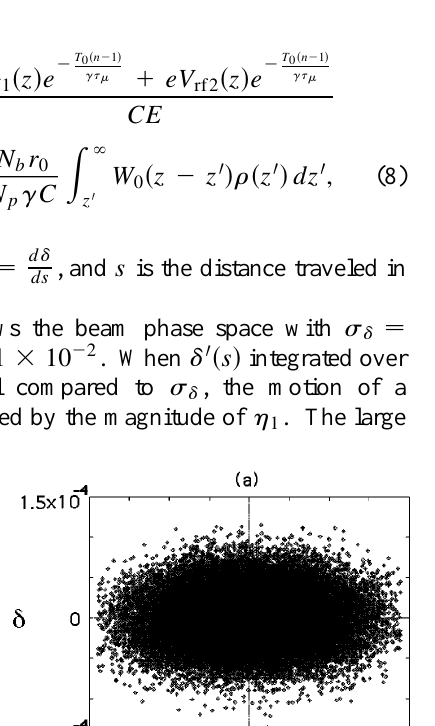
FIG. 5. The sensitivity of the longitudinal beam phase space to the variations of j (cid:90) respectively, and s d (cid:173) (cid:51) 3 (cid:49)(cid:48) 2 (cid:53) and h (cid:49) (cid:173) 2 (cid:49) 3 (cid:49)(cid:48) 2 (cid:54) . The voltages in the rf cavities are scaled linearly with j (cid:90) for the bunch wake. The effects of imperfect cancellation become more apparent at the higher impedances.